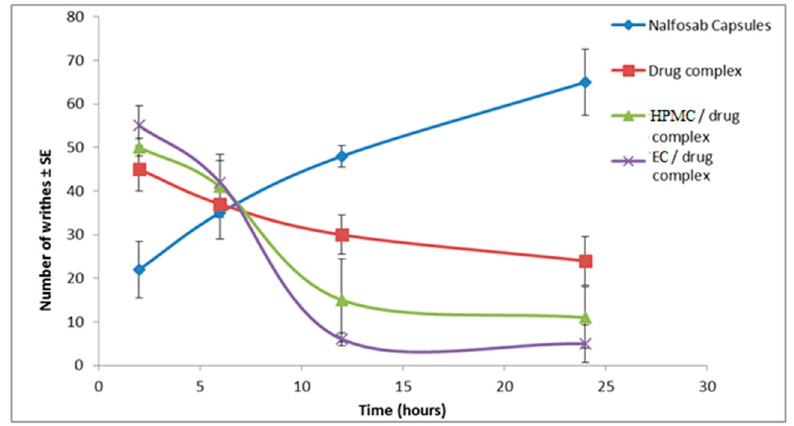
Figure 9. Effect of Nalfosab Capsules, drug complex, HPMC/drug complex and EC/drug complex on acetic acid induced abdominal writhing in mice.